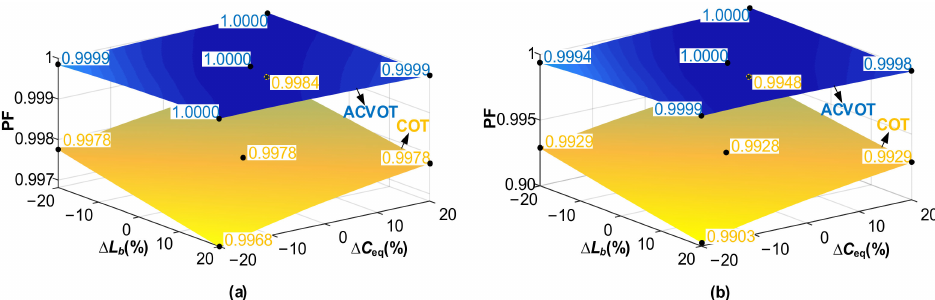
Figure 11. The PF surfaces with L b and C eq deviations: ( a ) 110 Vac; ( b ) 220 Figure 10. The THD surfaces with L b and C eq deviations: ( a ) 110 Vac; ( b ) 220 Vac.